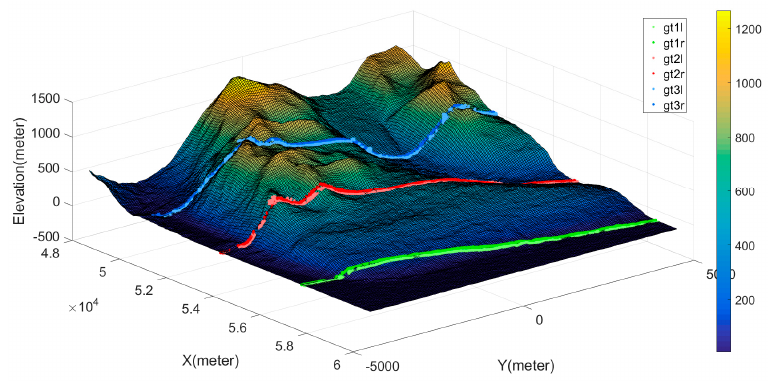
Figure 16. The ground tracks of ICESat-2 data. There are three pairs of beams; the red beam (gt2r) was selected as our experimental data. The gt2r track was used in the experiment. (1) Calibration using different track lengths.